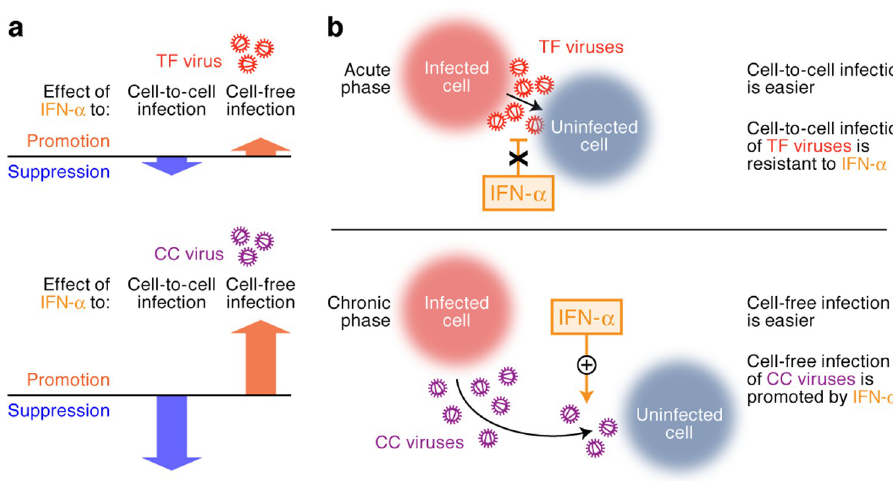
Fig 8. Graphical summary of this study. a Summary of phenotypic properties of TF and CC viruses observed in this study. CC virus (bottom) is positively (for cell-free infection) and negatively (cell-to-cell infection) sensitive to IFN- α stimulation, while TF viruses (top) is less affected by IFN- α stimulation. b Proposed hypothesis raised by this study. The detailed explanation is described in Discussion.